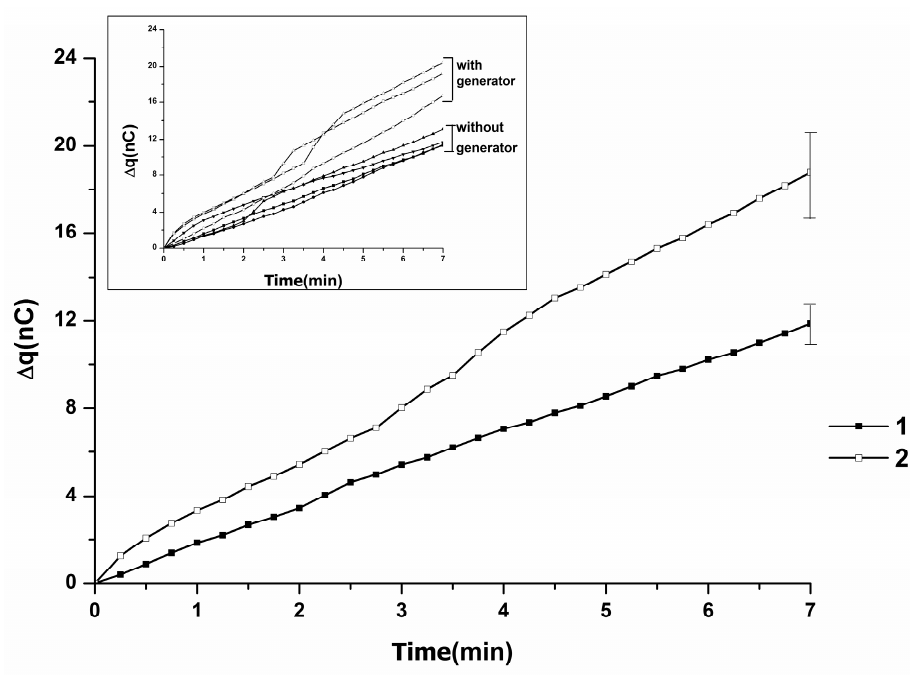
Figure 11. The effect of an external AC electric field on the charge generation in water. Averaged ∆ q(t) dependencies obtained upon flow of water through the injector nozzle in the absence ( 1 ) and in the presence ( 2 ) of an external electric field. Main graph presents averaged ∆ q(t) dependencies. Inset displays typical ∆ q(t) dependencies obtained in experiments upon pumping of water through the injector. Experimental conditions: ( 1 ) in the absence of an external electric field (“without generator”); ( 2 ) in the presence of an external electric field (“with generator”). Experimental conditions: ∆ U = − 100 V voltage, 50 Hz frequency, 35 ◦ C temperature, 15 µ L/s flow